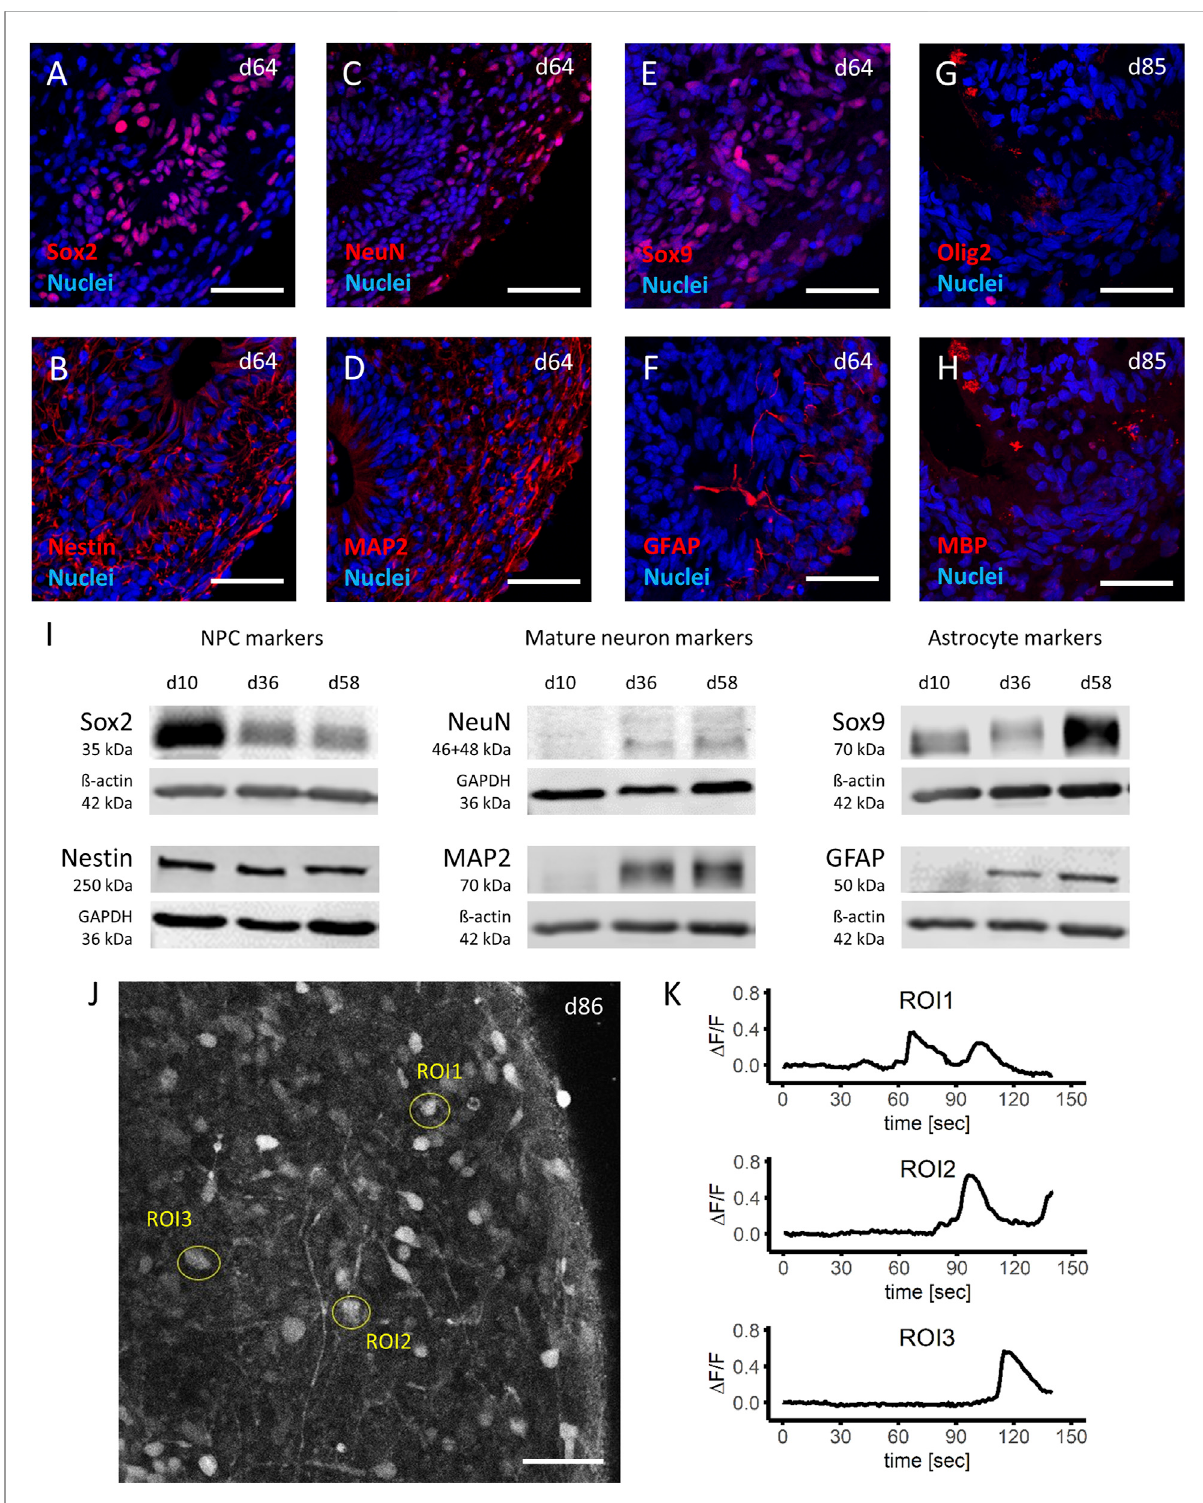
FIGURE 2 Characterizationofmature brainorganoids. (A – H) Immunohistochemistry analyses ofimportantcell typemarkers iniPSCderived human brain organoids show the presence of neuronal progenitor cells (NPCs) by expression of Sox2 (A) and Nestin (B) , mature neuronal cells by NeuN (C) and MAP2 (D) ,astrocytesbySox9 (E) andGFAP (F) atday64,aswellasoligodendrocytesbyOlig2 (G) andMBP (H) atday85ofthedifferentiationprotocol. (I) Westernblotanalysesofcelllysatesfromd10(NPCs),d36(earlyorganoids)andd58(lateorganoids),demonstrateadecreaseofNPCmarkers